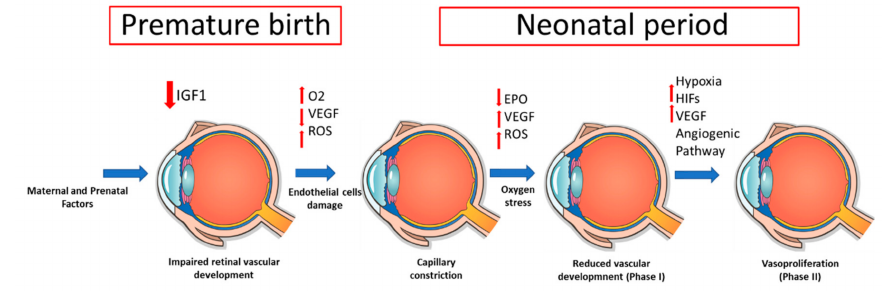
Figure 2. Description of the main known pathophysiological cascade of events leading to retinopathy of prematurity (ROP). Abbreviations: EPO, erythropoietin; HIFs, hypoxia-inducible factors; IGF-1, insulin-like growth factor 1; O2, oxygen; ROS, reactive oxygen species; VEGF, vascular endothelial growth